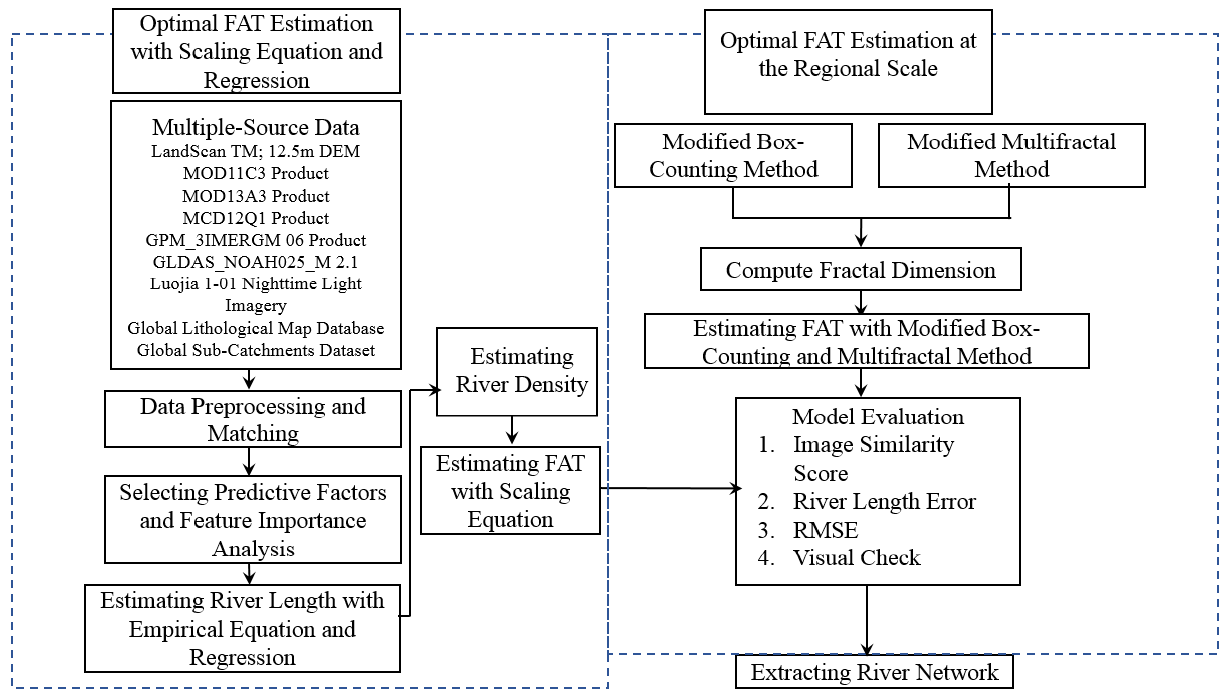
Figure 1. Flowchart of this paper’ s methodology.